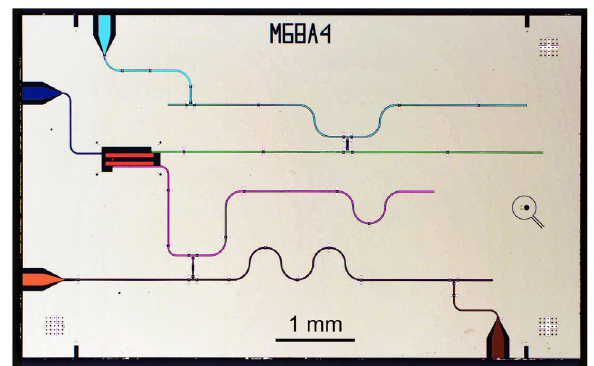
FIG. 5. False color micrograph of the detector sample. A transmon qubit (red) is coupled to the detection cavity (green) and its Purcell filter (light blue), as well as to a readout cavity (purple) and a corresponding Purcell filter (brown). A charge line (dark blue) allows for driving the qubit, and a weakly coupled input port (orange) allows for transmission measurements through the readout resonator. Sapphire is shown in dark gray, and niobium in light